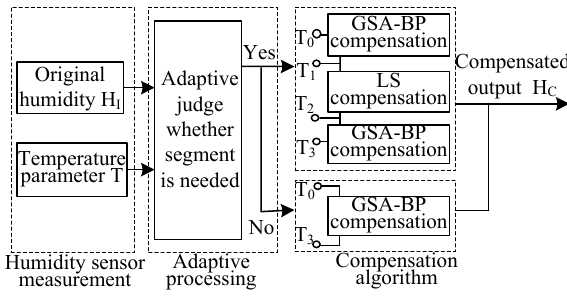
Figure 3. Compensation principle of humidity sensor.